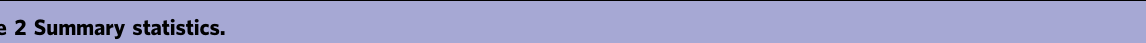
Table 2 Summary statistics.